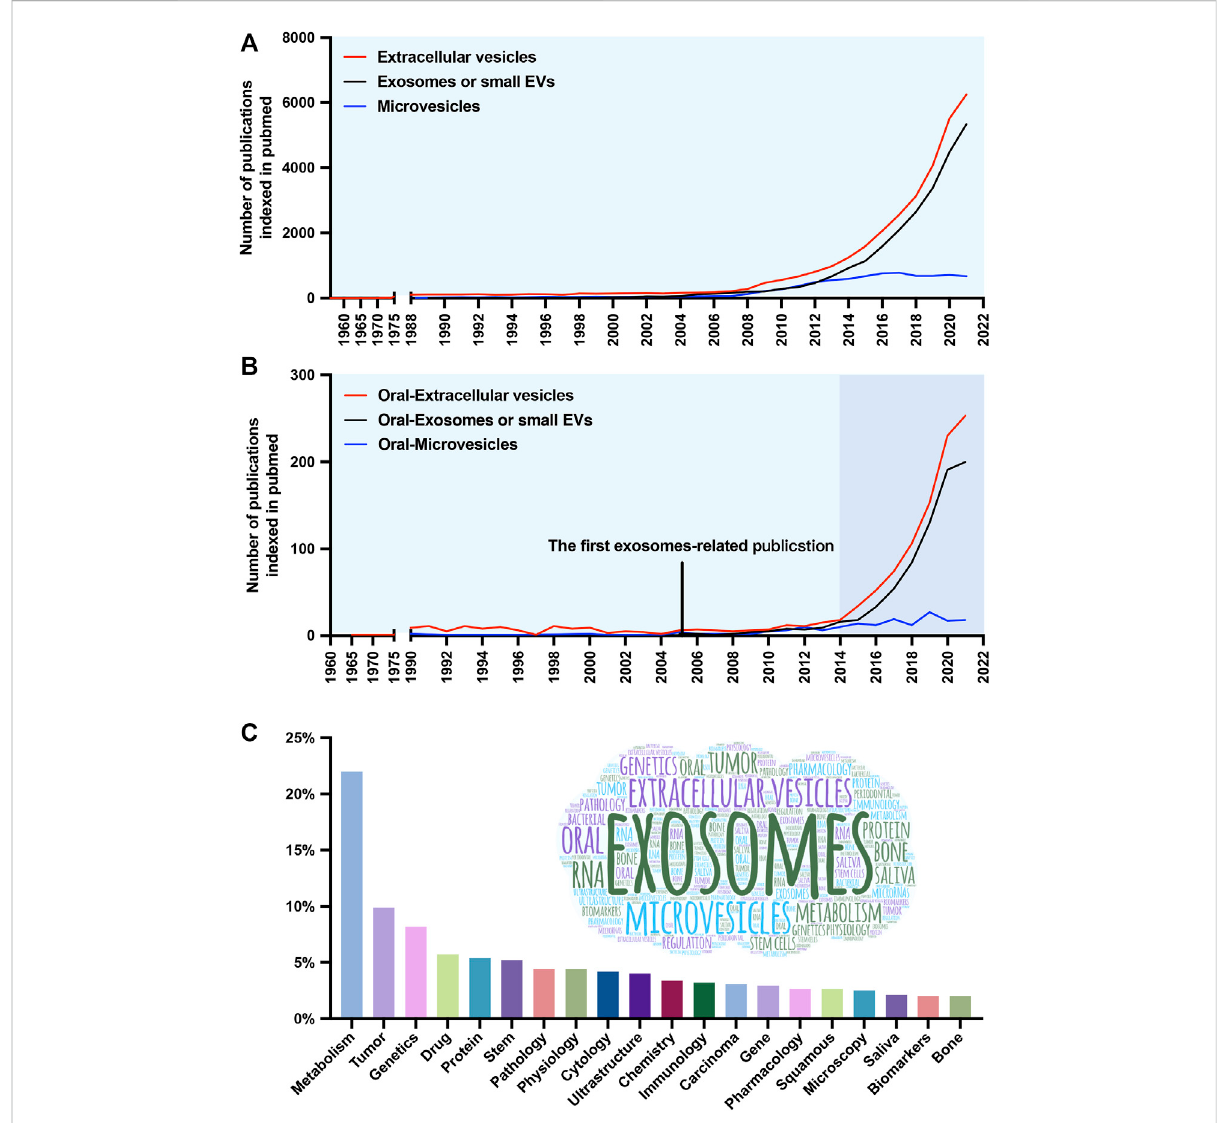
Number and keyword analysis of publications. (A) Timeline (1960 – 2021) of the publications referring to extracellular vesicles (EVs) (red line), exosomesorsmallEVs(blackline),andmicrovesicles(blueline). (B) Timelineofthepublicationsreferringtooral-extracellularvesicles(redline),oral- exosomesorsmallEVs(black line),andoral-microvesicles(blueline). (C) The